Question: Summarize what this figure shows in one sentence.
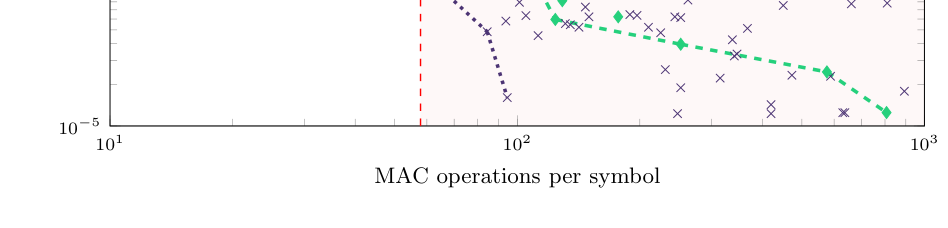
Answer: Results of design space exploration of the diﬀerent equalization approaches. The maximal MACsym to achieve the throughput of 40 GBd with a clock frequency of 200 MHz is given by the vertical red line. The Pareto optimal models of the CNN- based equalizer, the Volterra kernel, and the FIR ﬁlter are connected by the dotted, solid, and dashed lines respectively.